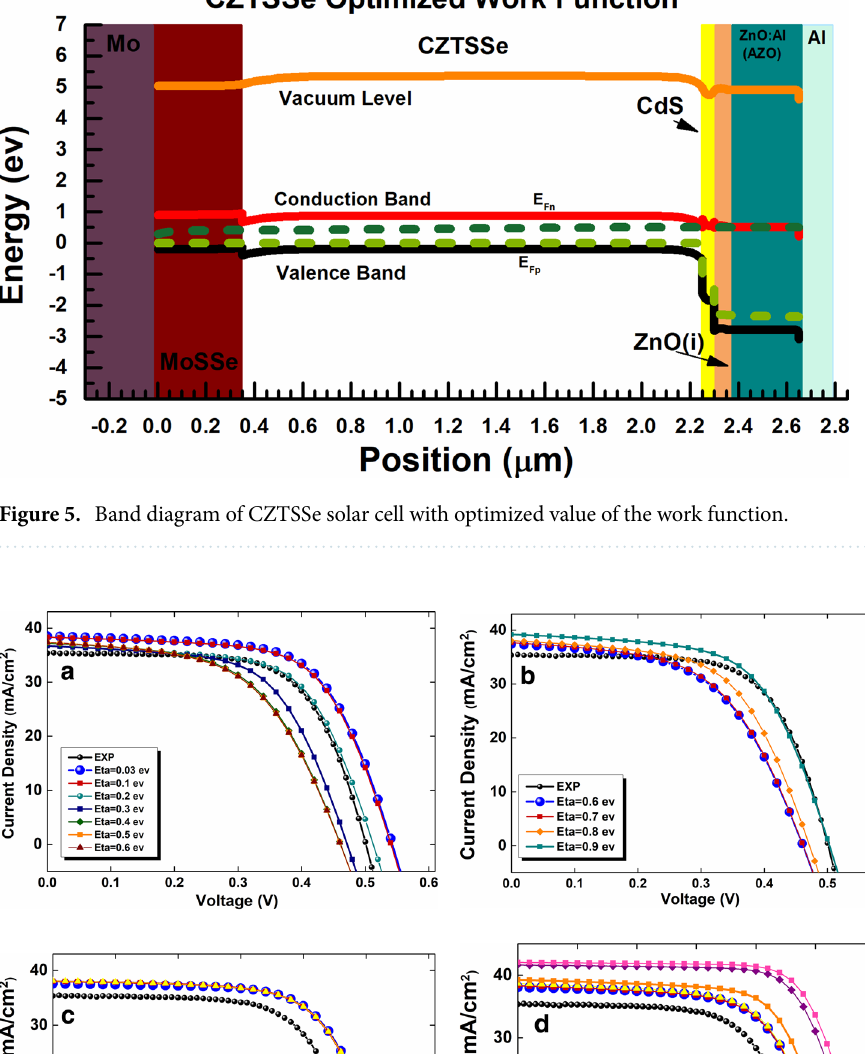
The average value of the electron Fermi level (E fn ) energy is 0.6 eV above the Valence Band Maximum (VBM) of the absorber layer. The effect of acceptor defects in the absorber layer [in the range of (1) 0.03 eV to 0.6 eV (Fig. 6a), and (2) 0.6 eV to 0.9 eV (Fig. 6b)] on the current density versus voltage (J-V) has been investigated. As indicated in Fig. 6a, acceptor defects with energy of E t = 0.03 eV record higher V OC and J sc , which improve the cell PCE. Therefore, E t , a = 0.03 eV is the optimum energy value for the acceptor defect, and we used that as a defect energy value for simulating our device to find out the optimum value for donor defect energy. Moreover, the investigation of donor defects positions has been done in range of (1) 0.35 eV to 0.55 eV (Fig. 6c), and (2) 0.55 eV to 1.02 eV (Fig. 6d). Consequently, we recorded an increment in open-circuit voltage (V OC ) and Jsc